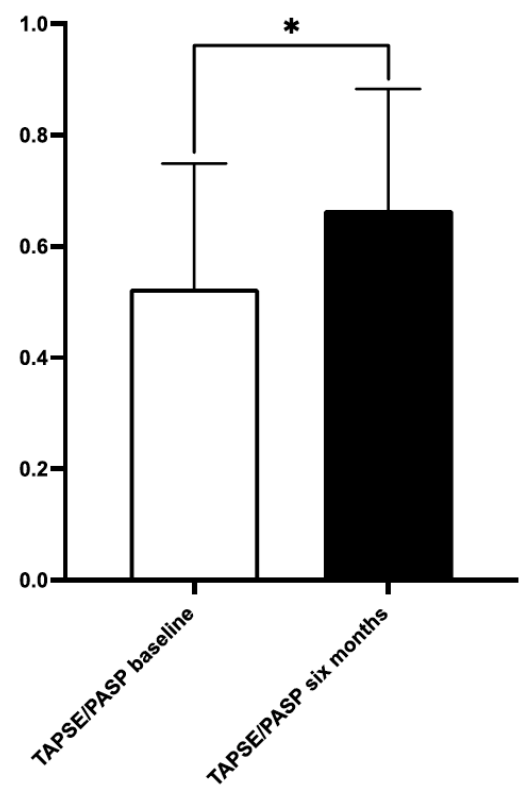
Figure 5. Effects of CCM on right ventricular arterial coupling.* = p < 0.05.